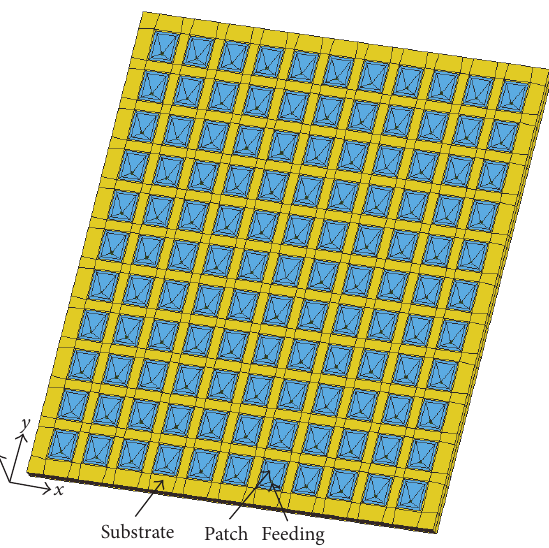
Figure 13: Model of the microstrip patch phased array.